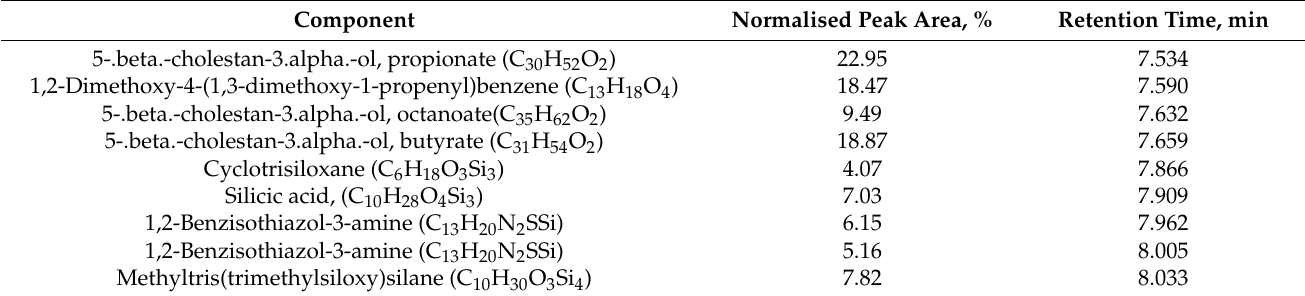
Table 5. Semi-quantitative composition of tar (GC-MS analysis) collected in the condensation stages during gasification of SSB6.